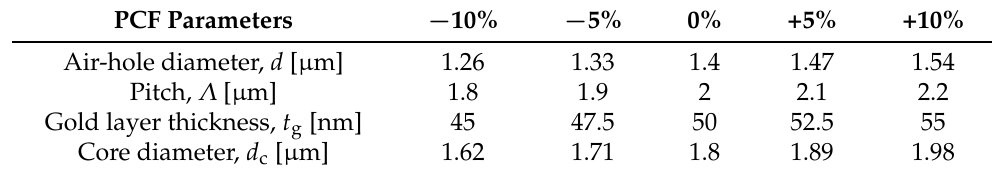
Table 8. Five-level Four Parameters ( ± 10% variations) and their values for DoE CCD Analysis.